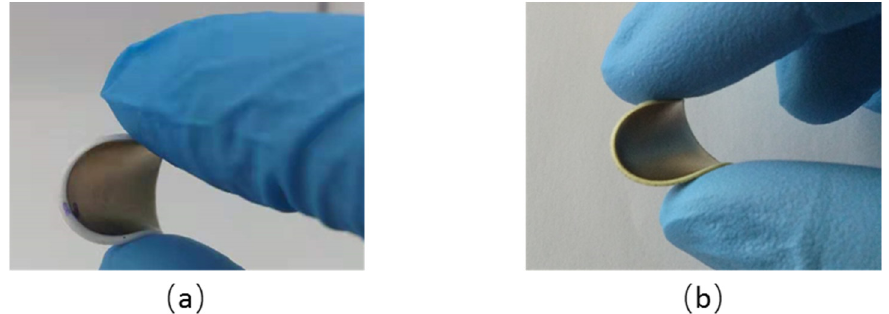
Figure 7. Elaborated flexible samples with 8% vol. of structured composite: ( a ) ZnO MRs/PDMS and ( b ) ZnO MPs/PDMS.